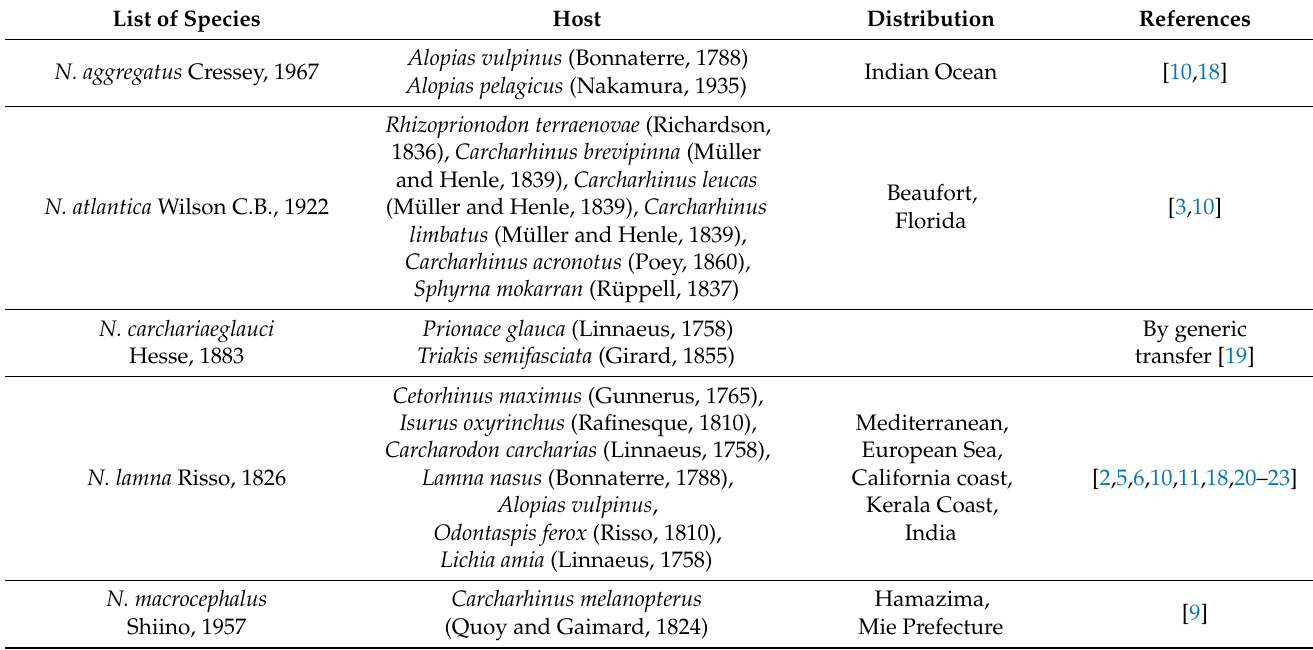
Table 3. List of valid species of Nemesis Risso, 1826, with their fish hosts and distribution